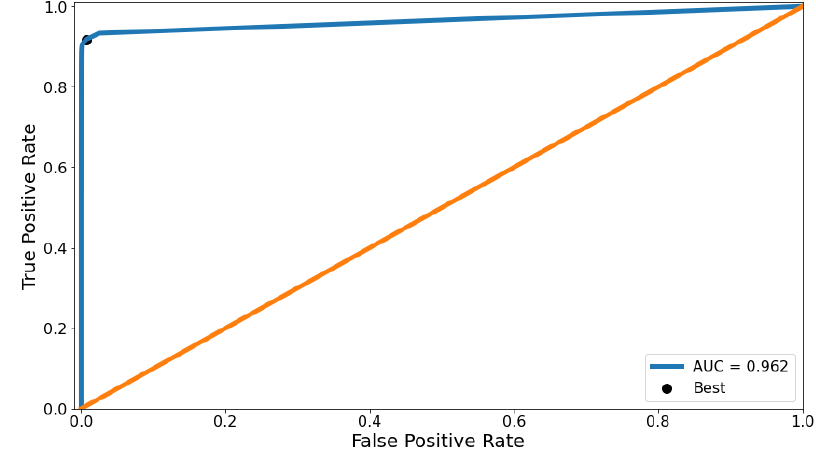
Figure 4. The ROC curve of AE-PRF.